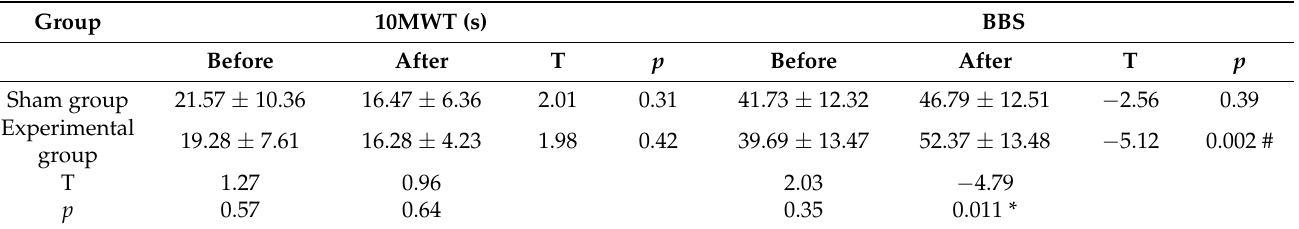
Table 4. The 10MWT and BBS